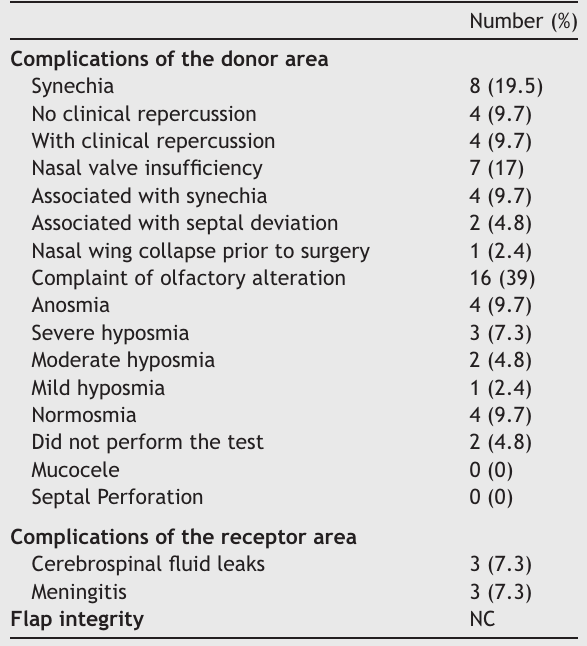
Complications from endonasal endoscopic surgery of the skull